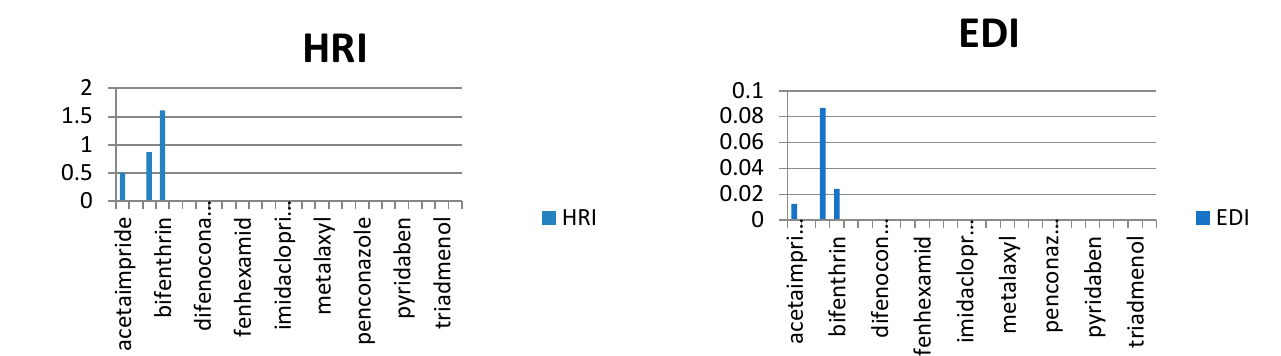
Figure 7. Estimation of EDI and HRI for pesticide residues detected in eggplant.